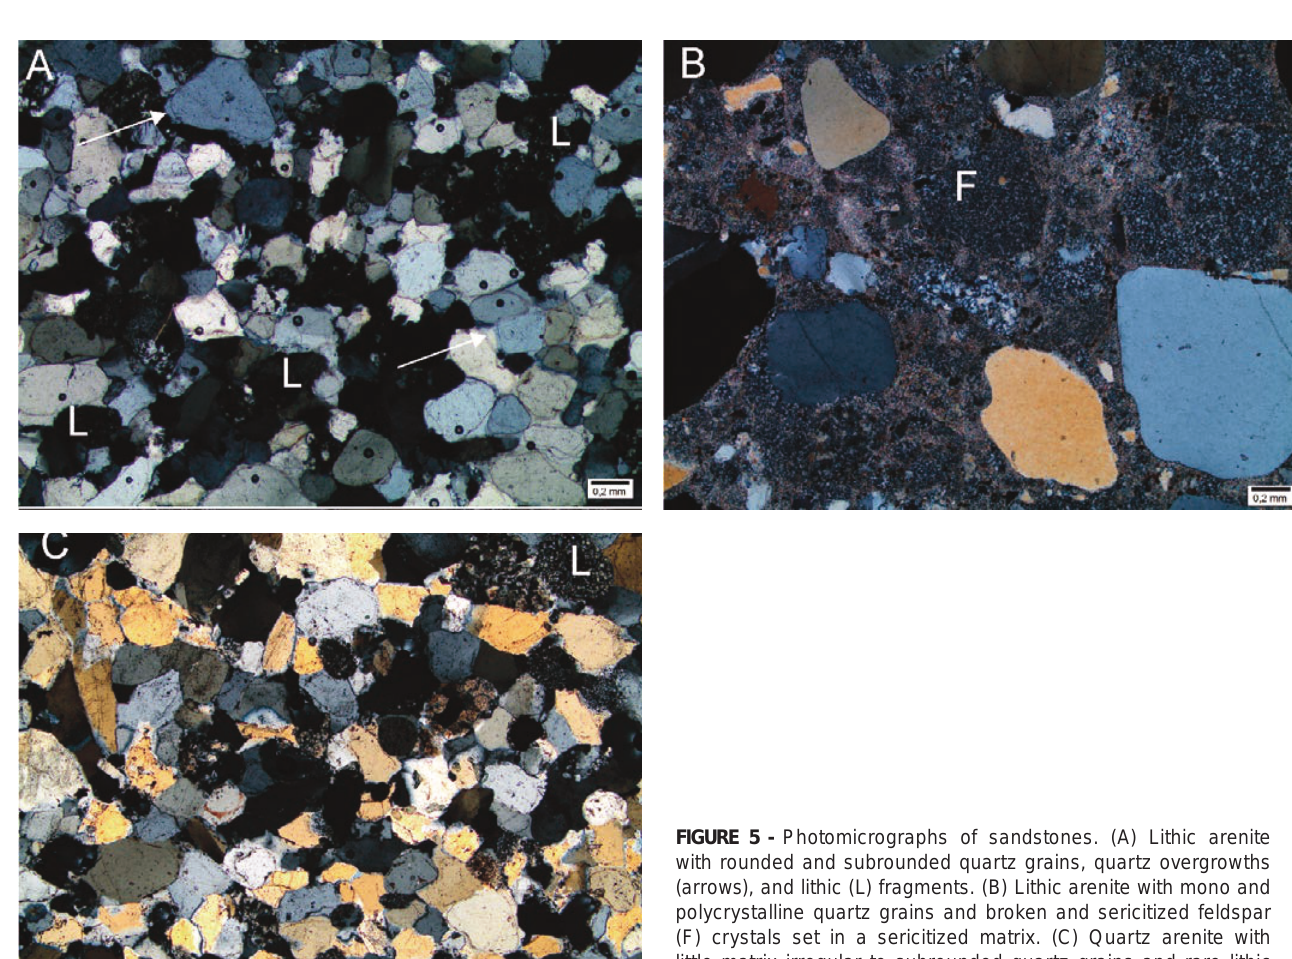
Figure 4 - Outcrop images of rock units of the Novo Progresso Formation. (A) Massive sandstone. (B) Sandstone with moderately dipping sedimentary bedding (S ) and internal stratification. (C) Detail of sandstone with plane-parallel and cross stratification. (D) Channeled 0 stratification in sandstone. (E) Laminated siltstones. (F) Package of brown siltstones with intercalation of light grey, fine grained quartz-rich (cherty) layers (detail in the inset).